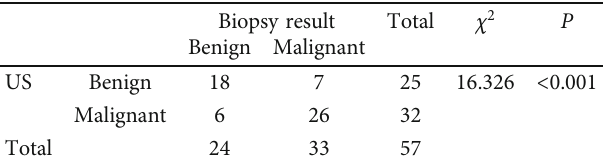
Table 7: E ffi cacy analysis of US and US +ECUS in the diagnosis of benign and malignant thyroid